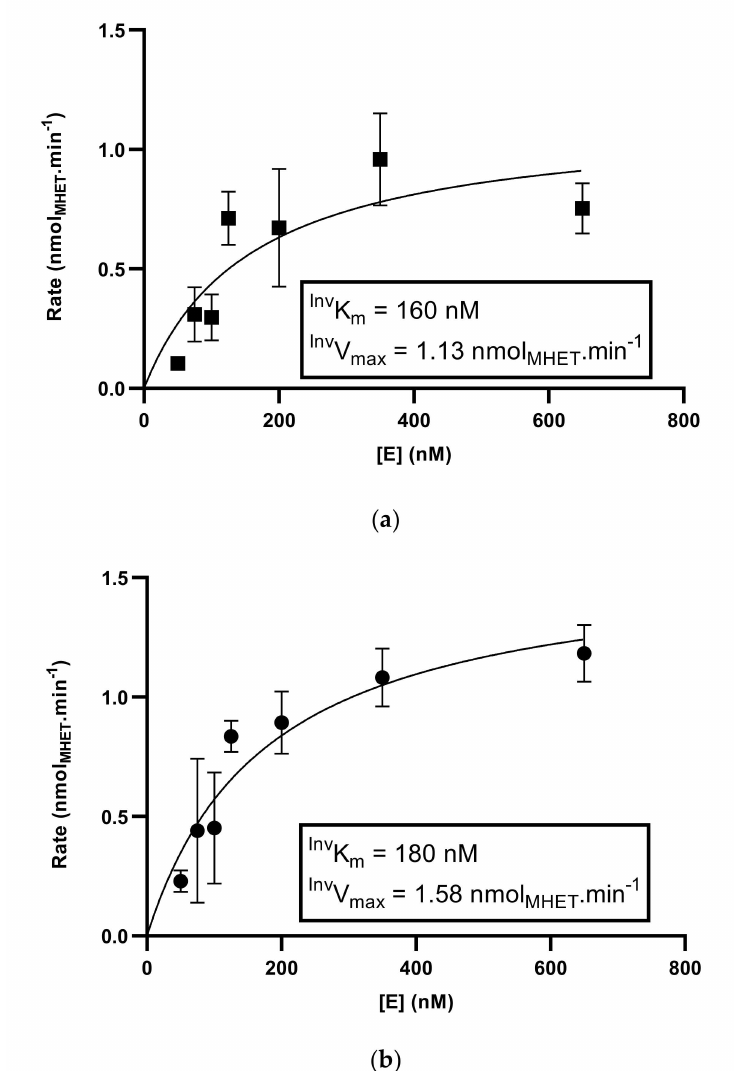
Figure 3. Determination of Inv Km and Inv Vmax for S136E PETase (panel ( a ) and Son PETase (panel ( b )) after 6 h of hydrolysis of a standardised PET disc at 30 ◦ C. The major product found by a concurrent HPLC analysis in all kinetic determinations was MHET, and given that the extinction coefficients of TPA and MHET are similar, concentrations are reported as MHET equivalents. Experimental values are shown as points on each graph. Error bars represent the standard deviations of triplicate measurements, and the line of best fit is fit to a Michaelis − Menten equation